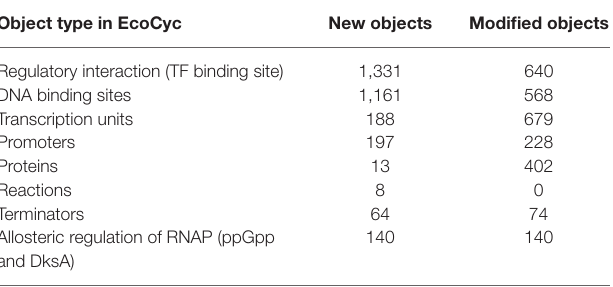
TABLE 2 | Summary of curation of the regulation of gene expression in EcoCyc between releases 21.1 and